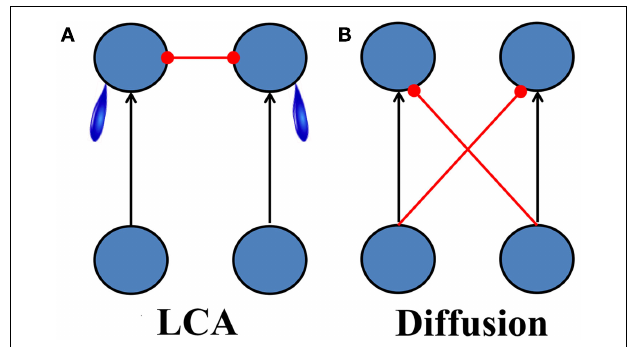
FIGURE 1 |Architecture of the two-choice reaction-time models. (A) The leaky competing accumulator model (Usher and McClelland, 2001), (B) Mazurek et al. (2003) model. Arrows and filled circles indicate excitatory and inhibitory connections respectively. Blue tears indicate